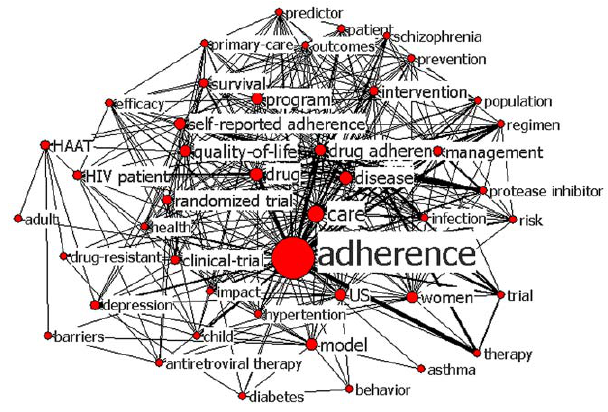
Figure 2. Map for keywords in adherence research, 2000–2005. The size of nodes indicates the keywords centrality, and the thickness of the lines indicates the co-occurrence frequency of keywords pairs.